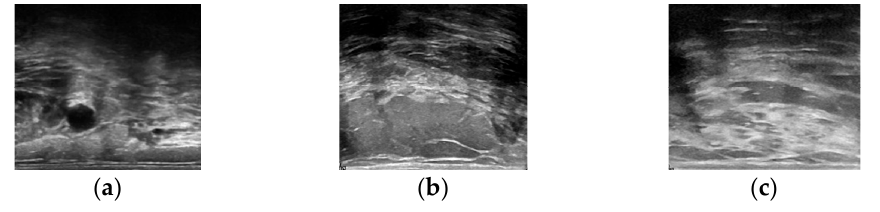
Figure 1. Representative images from BUSI dataset: ( a ) Benign; ( b ) Malignant; ( c ) Normal.